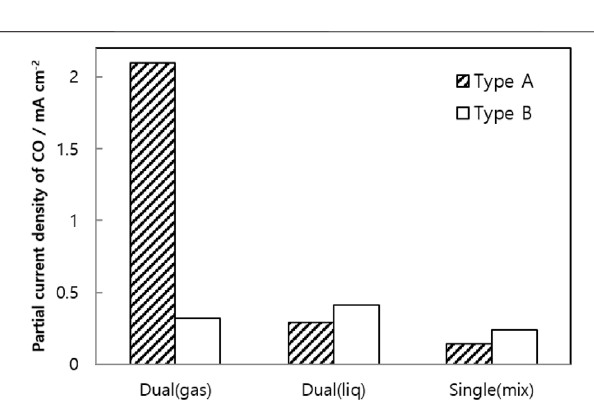
FIGURE 10 | CO partial current density of differently structured cells composedofsingleserpentineorintegratedchannelswithliquidorgasphase [Mixed supply, Single (mix)], liquid in the main channel with gas in the sub- channels [Dual (liq)], or gas in the main channel with liquid in the sub- channel[Dual(gas)]withthe fl uidinthemainchannelcontactedbythecatalyst layer (Type A) or the gas diffusion layer (Type B).